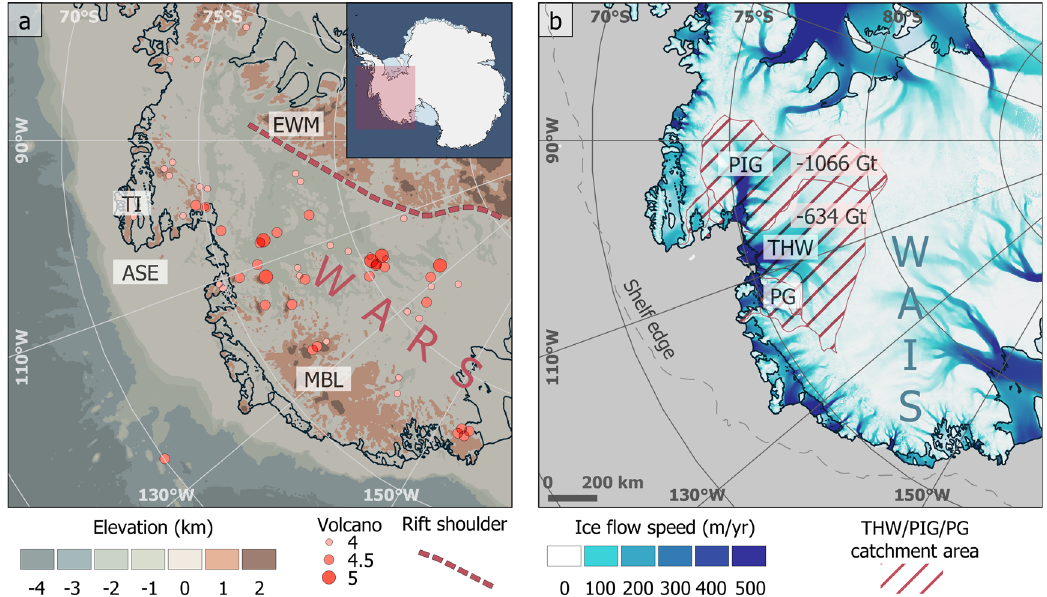
Fig. 1 Overview of the study region. a Map shows bed elevation 51 , rift shoulder of the West Antarctic Rift System (WARS), and locations of volcanoes 22 with a con fi dence factor of 4 or higher. Highlighted area indicates study region. EWM Ellsworth-Whitmore Mountains, ASE Amundsen Sea Embayment, MBL Marie Byrd Land. b Catchment areas of Pine Island (PIG), Thwaites (THW), and Pope (PG) glaciers which drain the West Antarctic Ice Sheet (WAIS) into the Amundsen Sea Embayment. Present day ice fl ow velocities are amongst the highest in Antarctica 52,53 . The cumulated ice mass loss of 4760 Gt for the Thwaites (THW) and Pine Island (PIG) catchment region over the last four decades (1979 – 2017) accounts for 36% of the total Antarctic ice mass loss 14